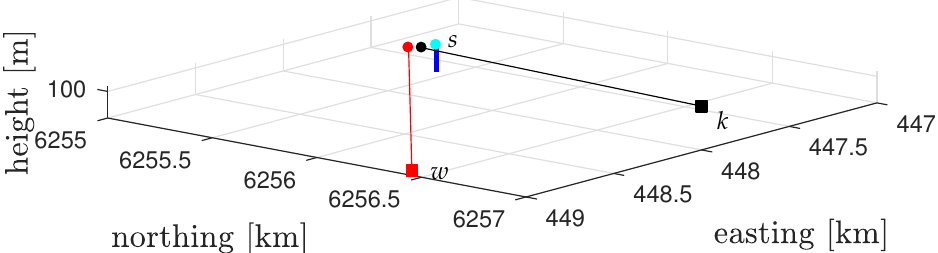
Figure 4. A sketch of the campaign at the Høvsøre Test Station in Denmark. The two WindScanners are shown in rectangles ( k in black and w in red), their beams with similar color, the meteorological mast in blue with a 100-m sonic anemometer s in cyan. Coordinates are in UTM 32,